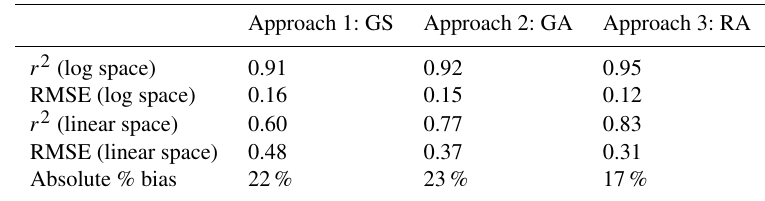
Table 2. Results of the comparison between model “actual” and model “satellite-like” derived Chl a for the three algorithm approaches discussed in Sect. 3. Statistics are calculated for each grid and each day over 13 years, except for grid cells and times with low light, very low Chl a and shallow regions (see text).